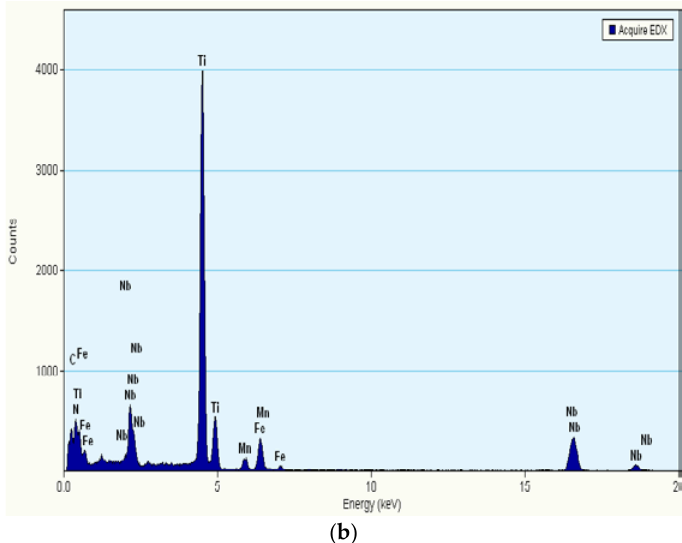
Figure 3. Precipitation of carbonitride (Ti,Nb)(C,N) with numerous small dispersive precipitates corresponding to the hardening of the steel. ( a ) recipitation of carbonitride (Ti,Nb)(C,N), ( b ) large particle-related EDX spectrum.